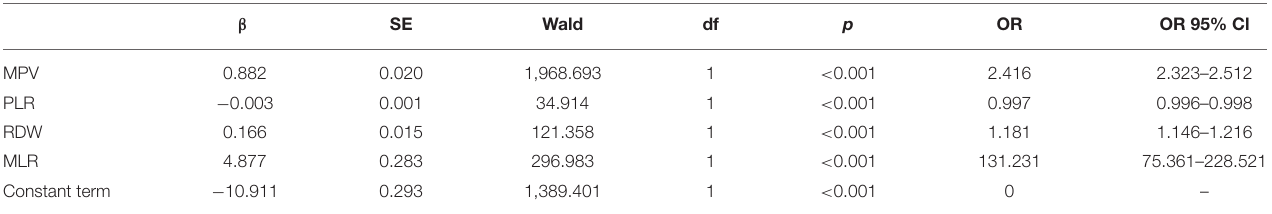
TABLE 4 | Peripheral biomarkers of inflammation derived from CBC of logistic regression model with risk factors of schizophrenia compared with healthy control groups. β SE Wald